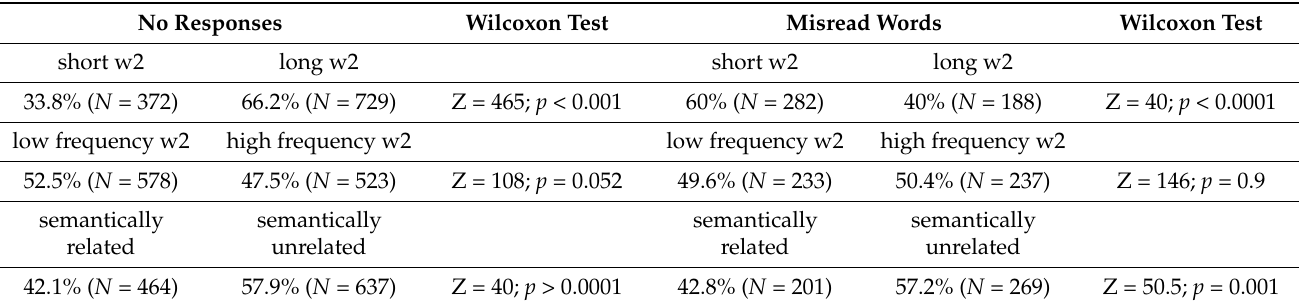
Table 2. Number and percentage of no responses and misread words in the different experimental